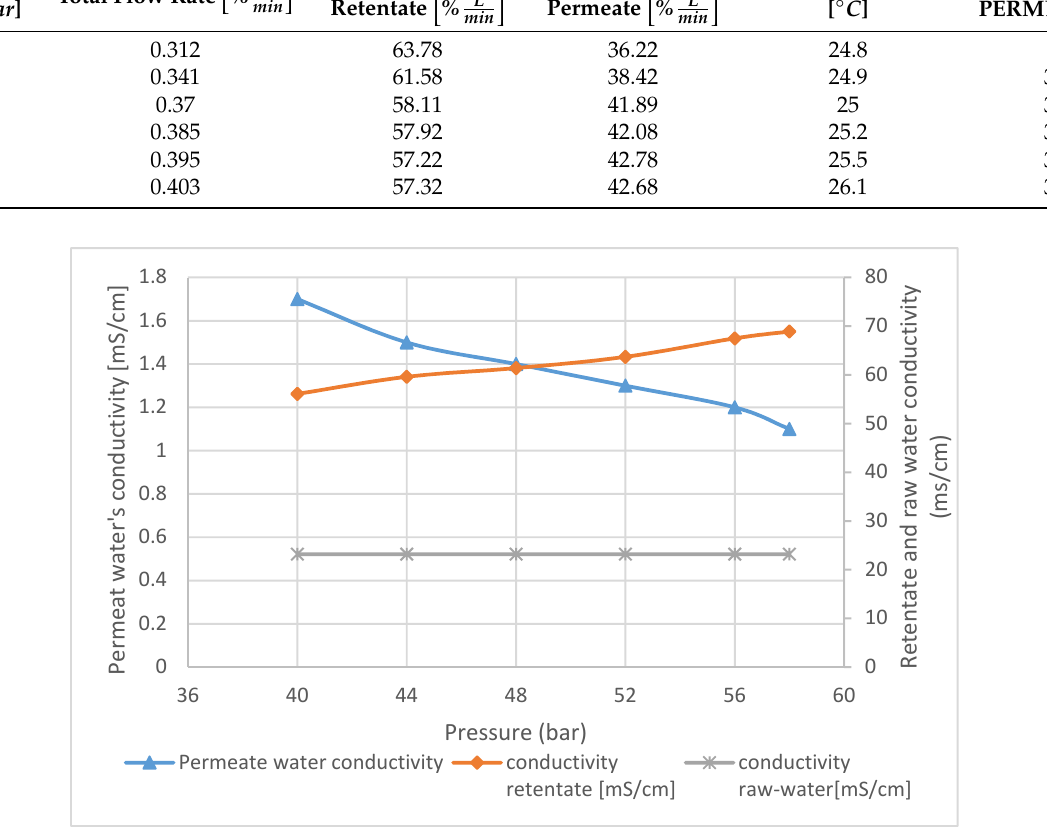
Figure 7. Water Conductivity (mS/cm).